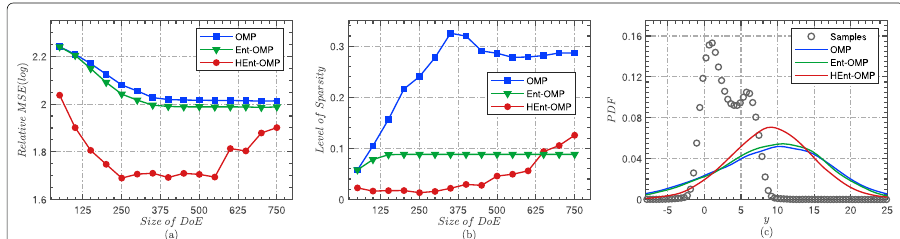
Fig. 6 Performance comparison of OMP, Ent-OMP and HEnt-OMP w.r.t. the OAKLEY & O’HAGAN function. ( a ) The relationship between the relative MSE and the size of DoE; ( b ) The relationship between the sparsity